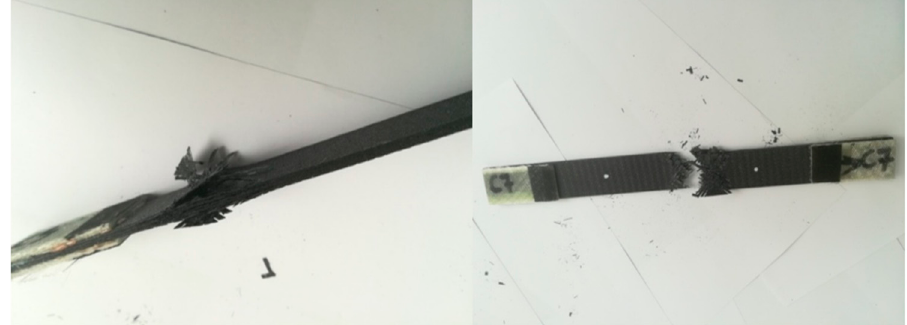
Figure 17. The appearance of samples from the C series after tensile bench testing.